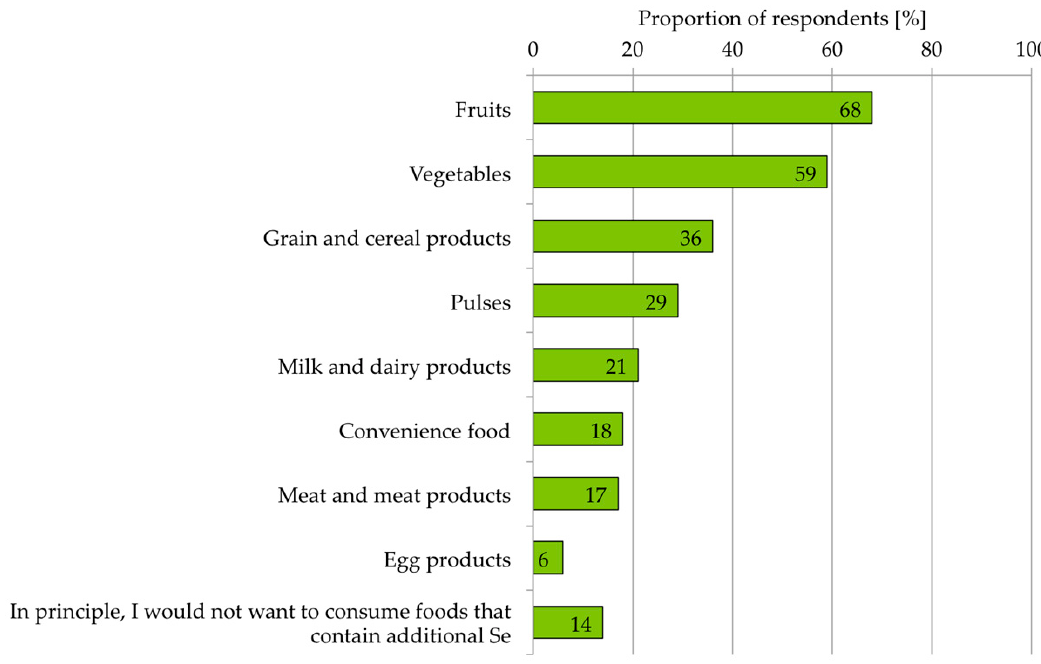
Figure 1. Suitability of different food categories for optimizing the Se intake through daily nutrition according to the participants surveyed. n = 291.